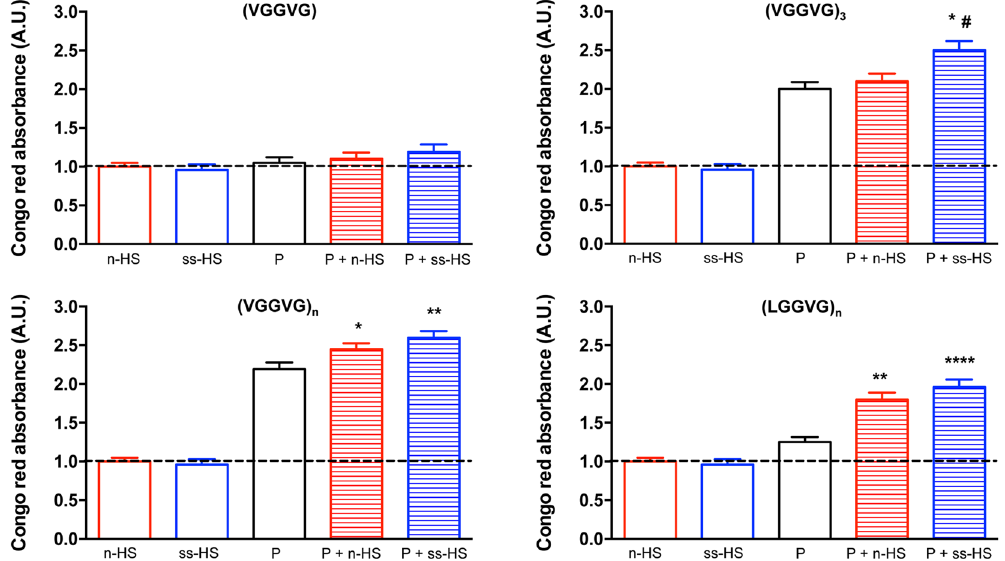
Figure 3. Spectroscopic assay by Congo red (CR). Natural (n-HS) or semisynthetic (ss-HS) heparan sulfate alone or elastin-like peptide (P) alone or their mixture were mantained for 24 h at 37 °C in acqueous solution. Data are normalized to CR background set at 1 (dotted line) and are expressed as the mean ± SD of three experiments. * p < 0.05; ** p < 0.01; **** p < 0.0001 peptide vs other conditions; # p < 0.05 peptide + n-HS vs same peptide + ss-HS.